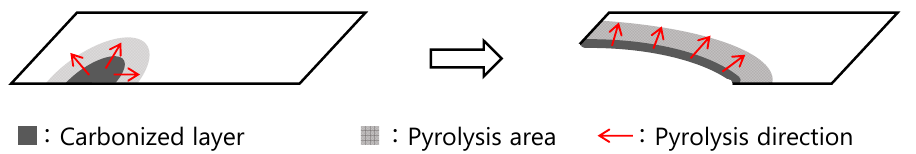
Figure 9. Micrographic image of the dark carbonized area of the cellulose char obtained at 1.0 kW after 5 s.